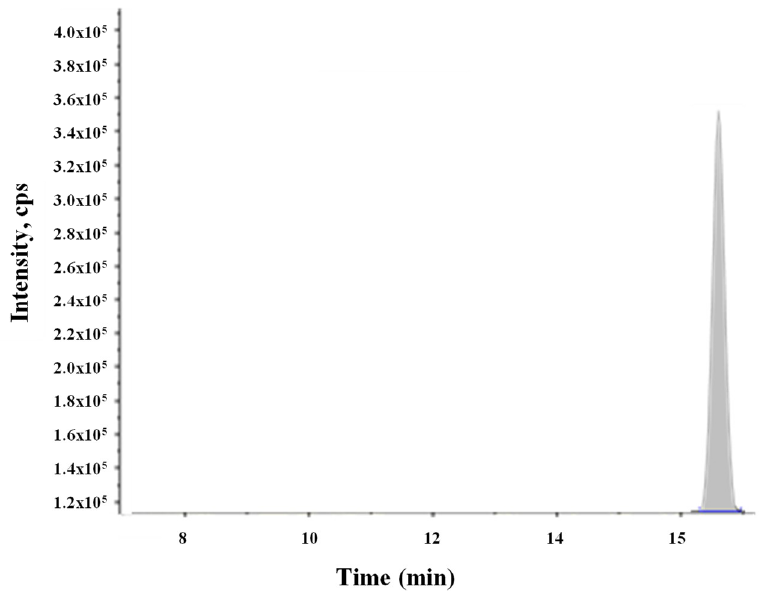
Figure 1. showing ENN BB added to a gula substitute sample. Figure 1. Showing ENN BB added to a gula substitute